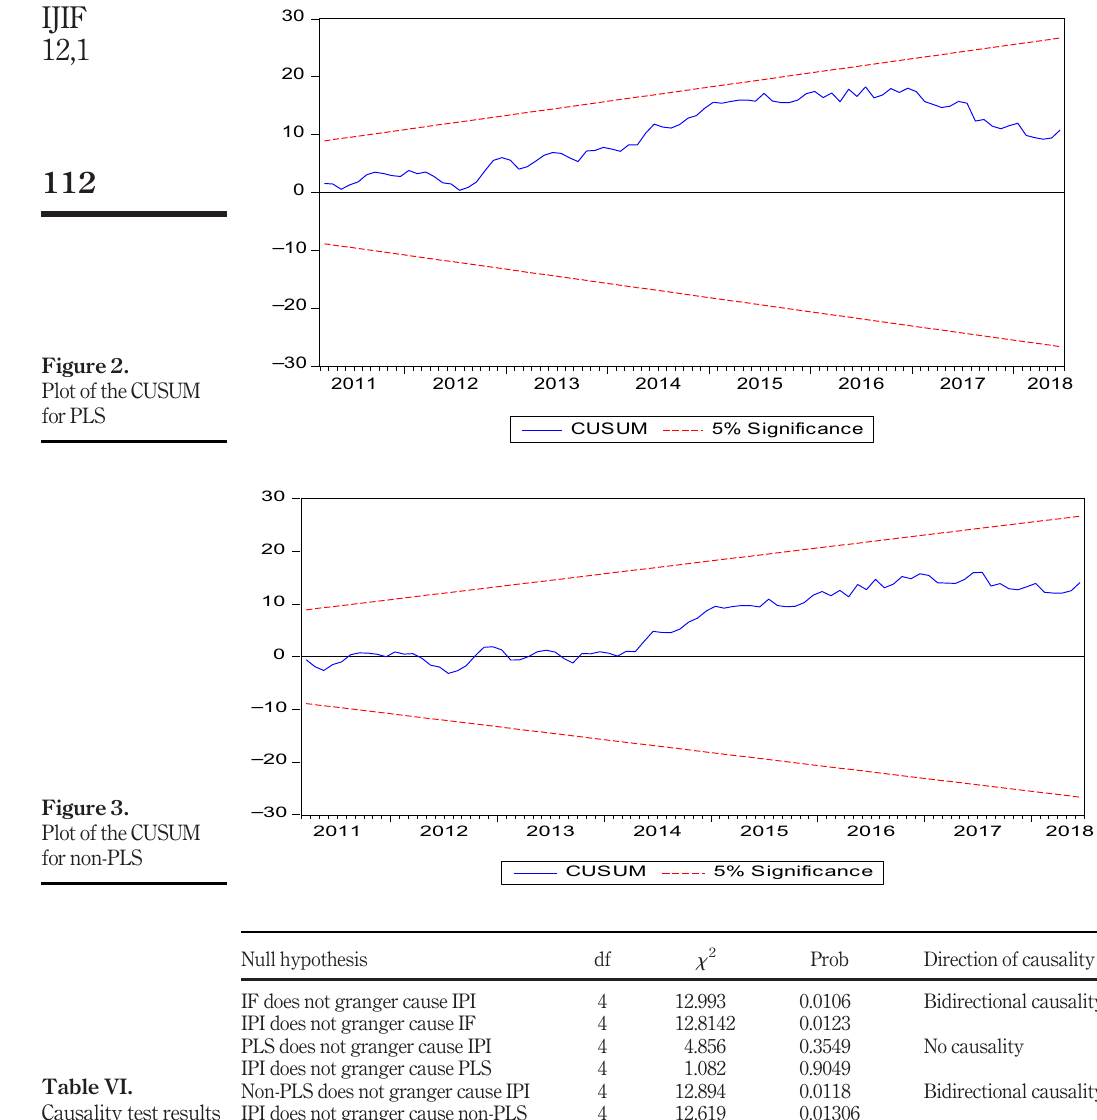
Table VI. Causality test results estimate the optimal lag length k , Akaike information criterion and SBC are used. The empirical results of the causality test reported in Table VI reveal the existence of a bidirectional relationship between industrial production and Islamic banking as measured either in aggregate terms or in terms of non-PLS only. In contrast, there is no causality relationship between PLS and industrial development.